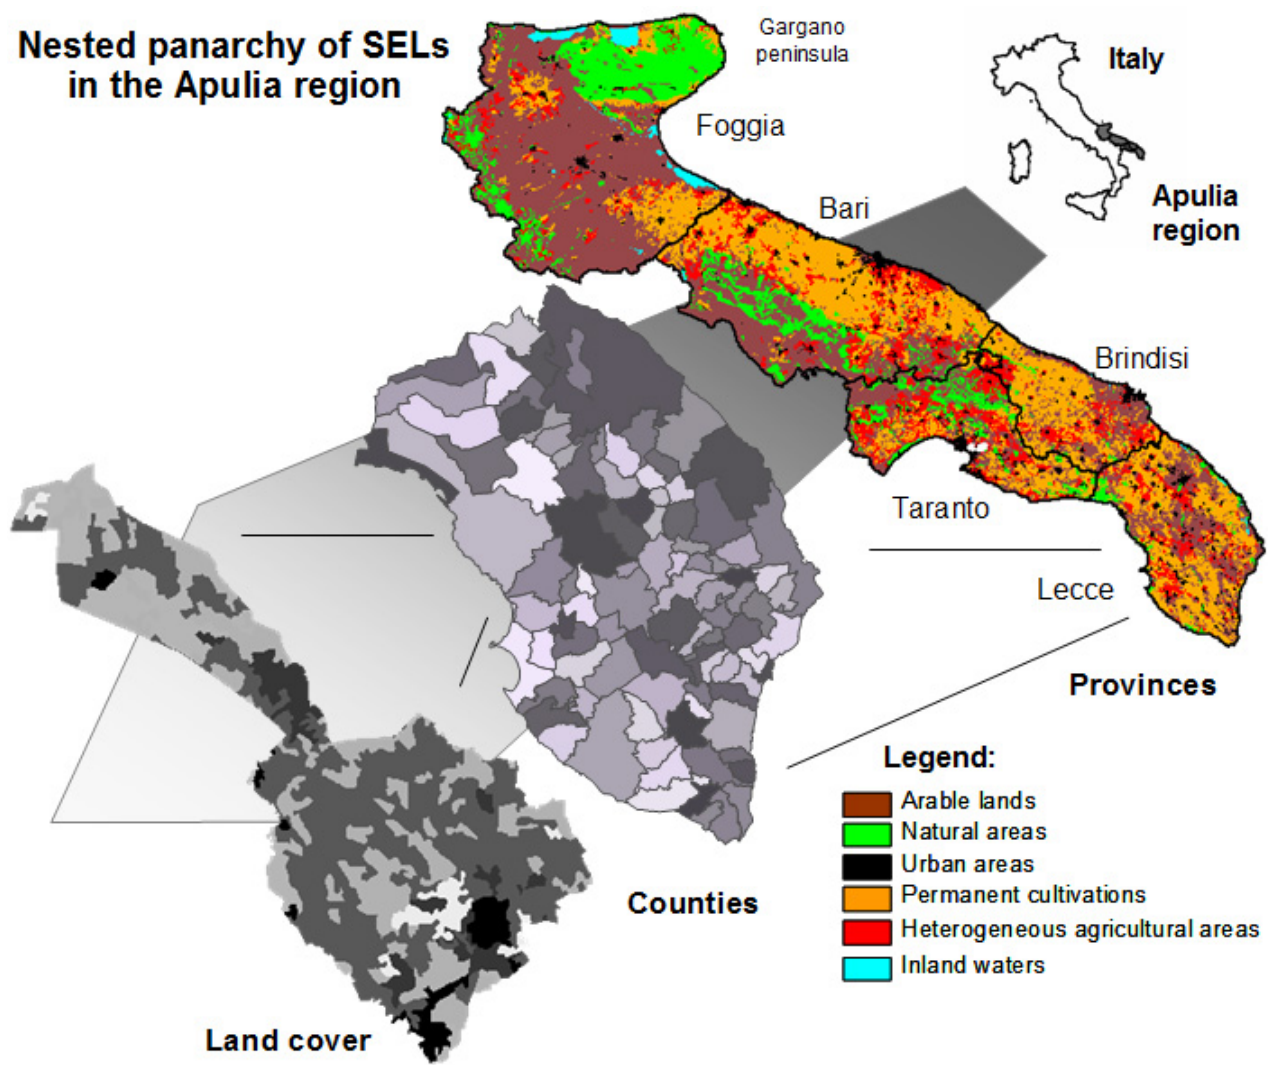
Fig. 1. Panarchy of nested jurisdictional levels defined as clearly bounded and organized jurisdictional units in Apulia, an administrative region of 1,936,000 ha in south Italy. Three main jurisdictional levels can be identified (region, province, county): one unit for the region, five units for the province level, and 258 units for the county level. The entire region or each sub-unit in the panarchy can be described in terms of their unique social-ecological landscapes (SEL) based on land-use composition. Six broad land- use/land-cover classes (top) and a simplified example of Corine land-cover map for one county (down) are presented. The original Corine land-cover map (1:100.000) updated at 1999 has a global accuracy of 88.1% and a Cohen's K coefficient of 0.84 (APAT 2005). Our use of broader land-use/land-cover categories improves upon that classification